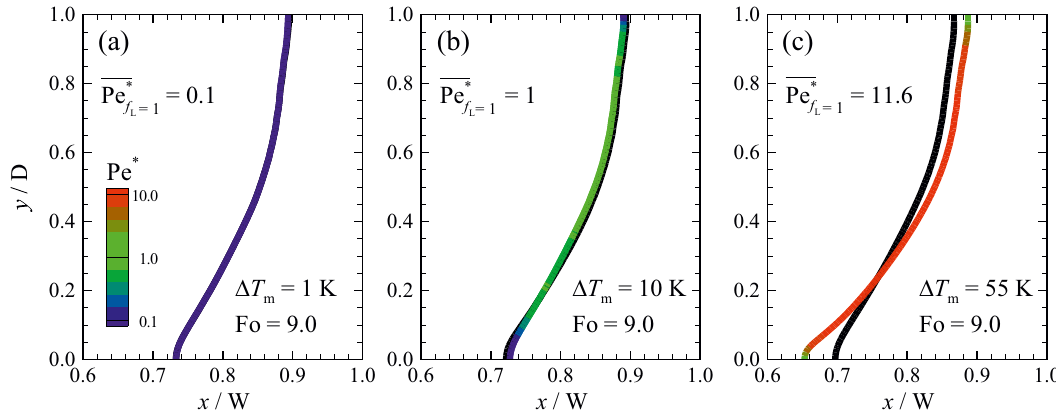
Figure 13. Melting front positions ( f L = 1) for the problem described in Section 2 ( ∆ T w = 750K and Ra = 10 6 ) at the steady-state condition (Fo = 9) and values of Pe ∗ along the melting fronts for: ( a ) ∆ T m = 1K; ( b ) ∆ T m = 10K; and ( c ) ∆ T m = 55K predicted using different permeability coefficients of C = 10 4 kgs − 1 m − 3 (coloured lines), and 10 8 kgs − 1 m − 3 (black lines). Values of Pe ∗ along the melting front are O ( 0.1 ) , O ( 1 ) and O ( 10 ) for ∆ T m = 1K, 10K and 55K, respectively. The results are more sensitive to the permeability coefficient for large Pe ∗ . For the case with ∆ T m = 1K (a), predictions with different permeability coefficient are identical and therefore the coloured line covers the black